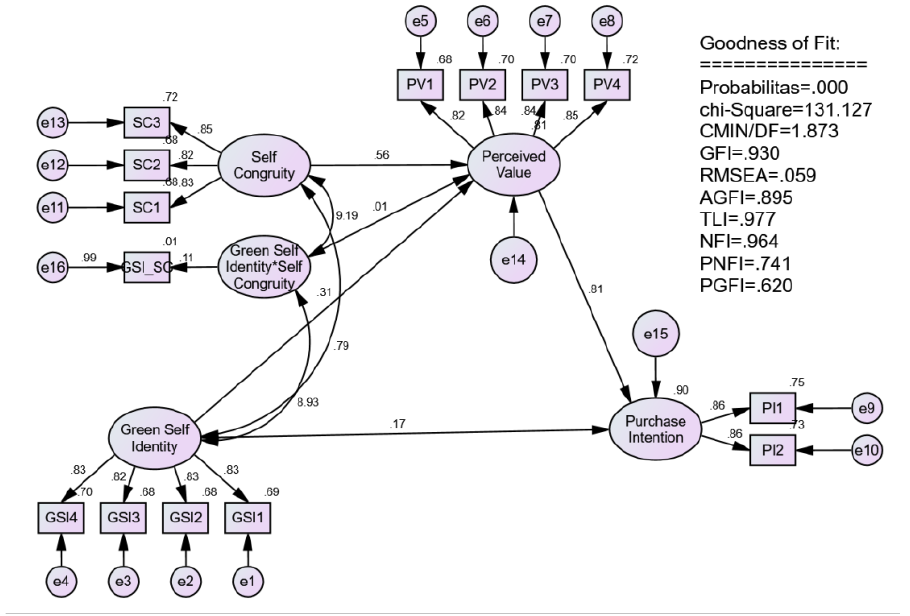
Figure 2: Estimation